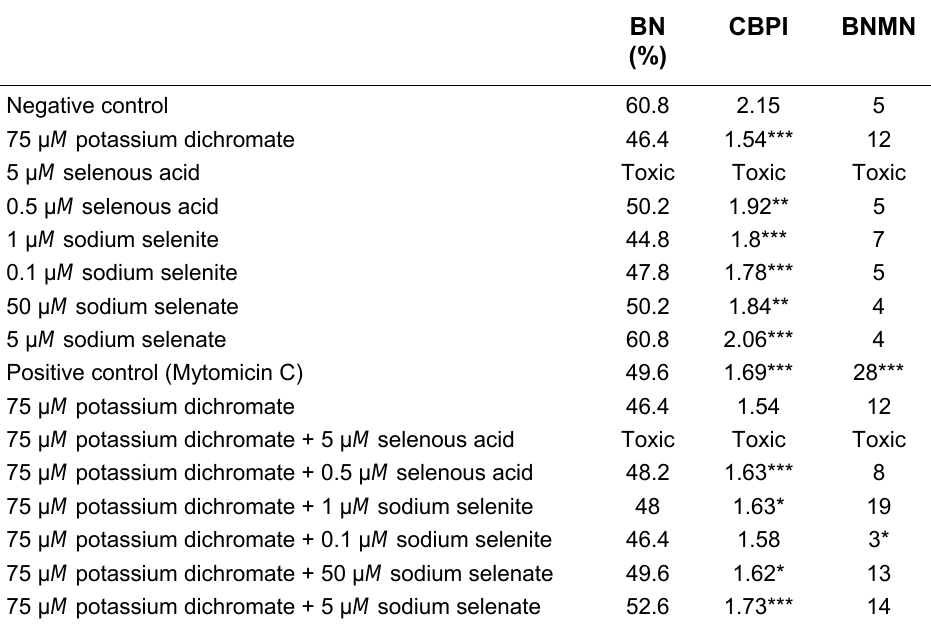
Assays Conducted with 75 μ M Potassium Dichromate and Selenium Compounds in Whole Blood BN